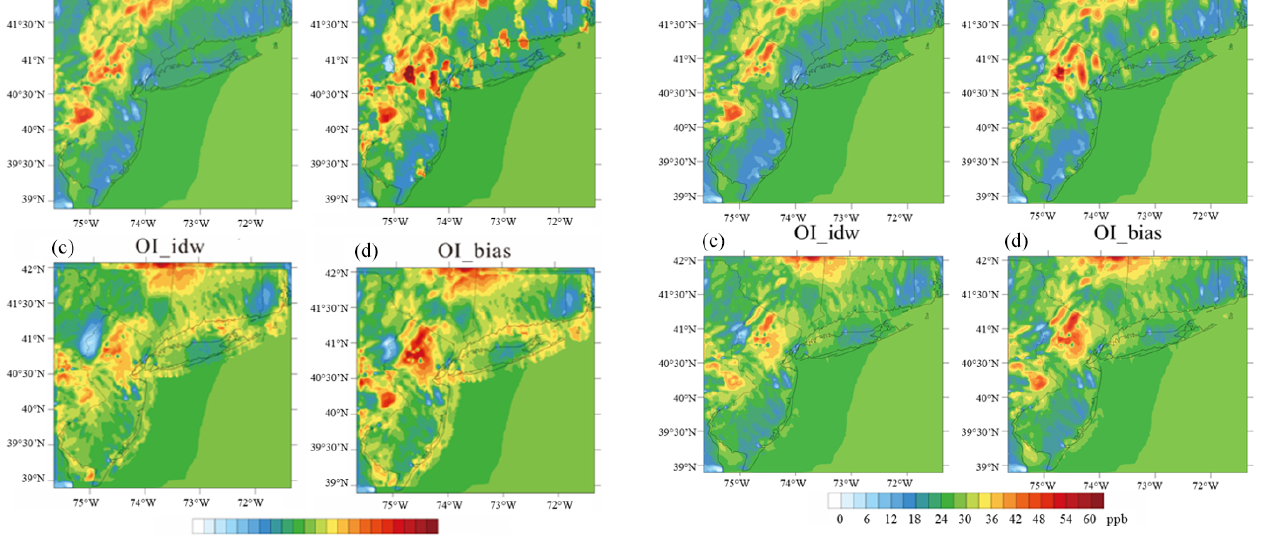
Figure 4. The concentrations of surface O 3 in initial conditions file at 00:00UTC on 26 August 2018 adjusted by OI_avg, OI_idw and OI_bias.